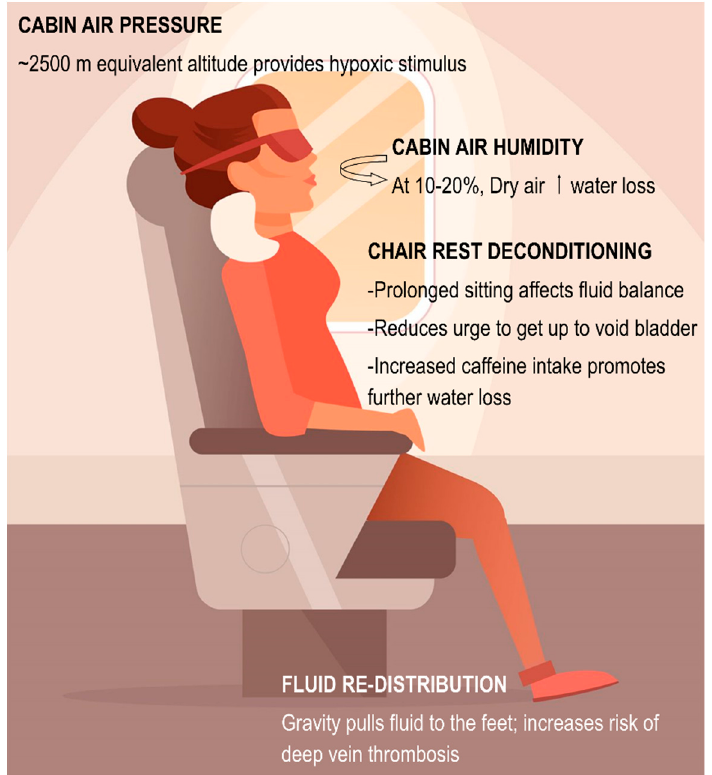
Figure 1. Air cabin environment creates a unique situation that promotes possible increased risk for dehydration and fluid shift en route to the destination which may be further exacerbated by the behavior of the individual and independent of jet-lag-induced alterations in circadian rhythm.